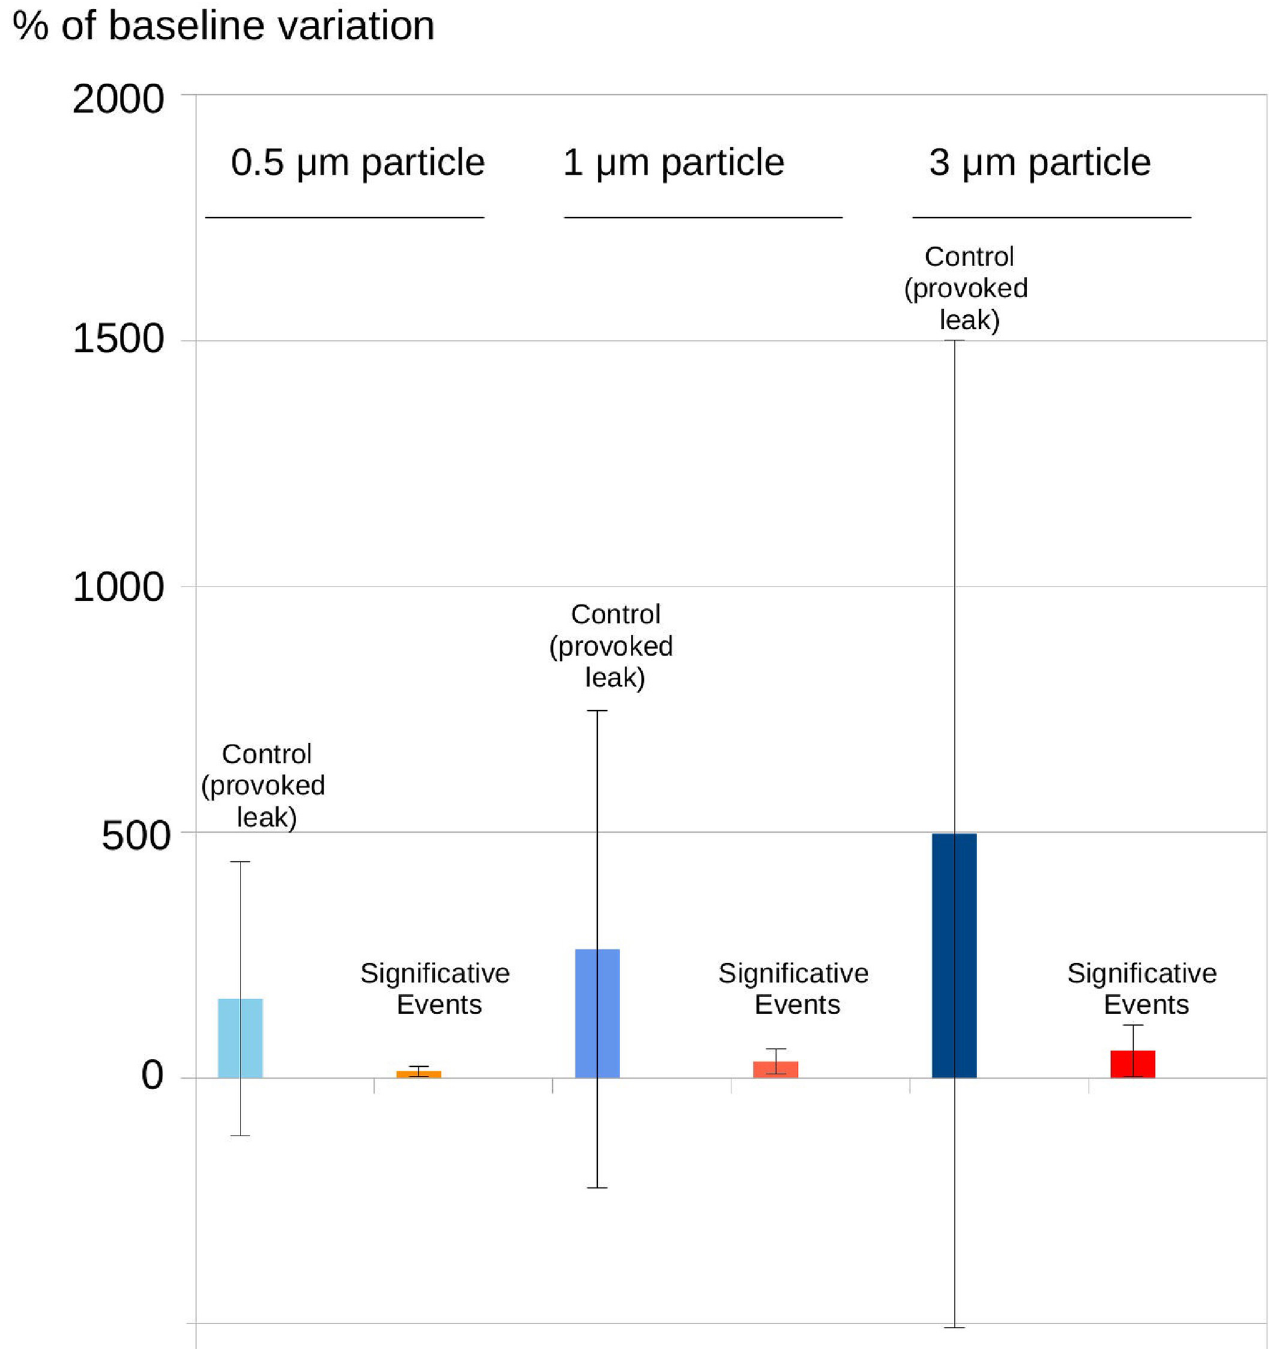
Fig 6. Comparison of variations on particle count induced by control leaks and significant events during the whole procedures: The significant events generate lower levels of particles than controls.